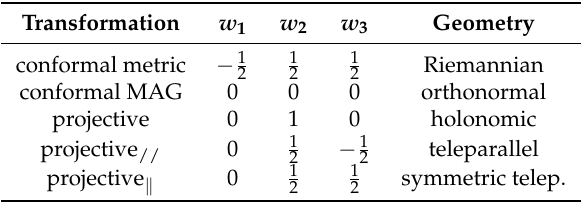
Table 1. The projections of the affine connection Equation (4), or Equation (5), in terms of the vector distortion parameters in generalised Weyl geometry [26,66].